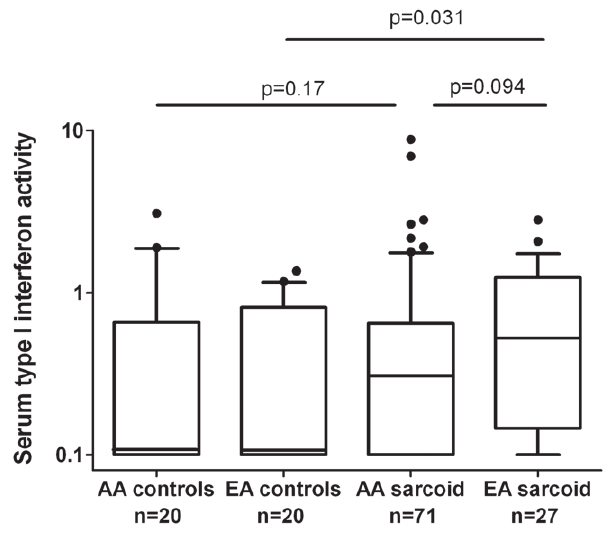
Figure 2. Serum type I IFN activity in sarcoidosis patients and controls in each ancestral background. Lines represent the median, boxes show the interquartile ranges, and error bars show the 10 th and 90 th percentiles with dots indicating outliers. P-values by Mann-Whitney U test.